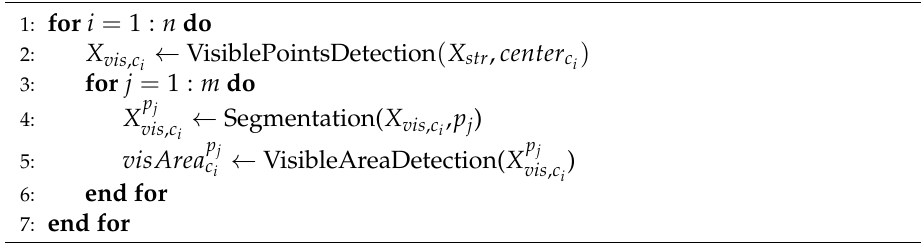
Algorithm 3 Visible area detection in the